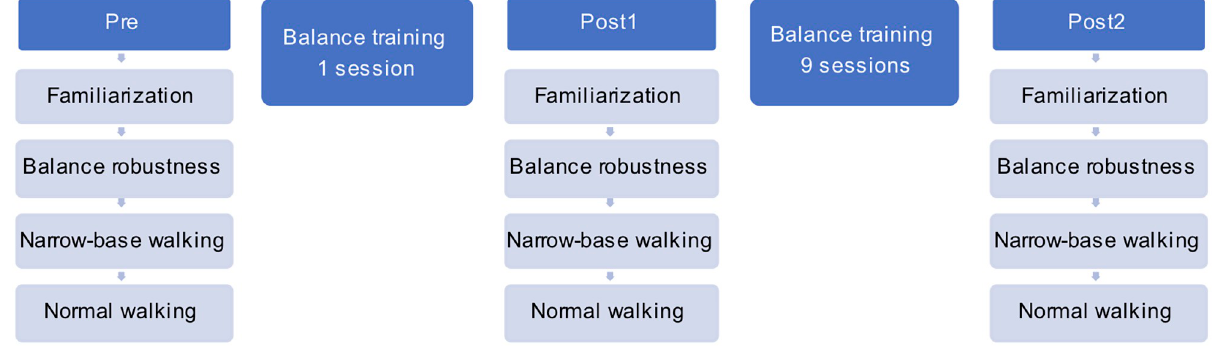
Fig 1. Block diagram of the study; training and gait